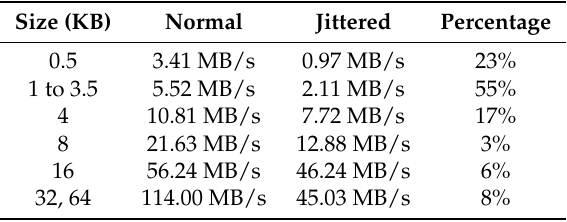
Table 6. Performance Comparison.